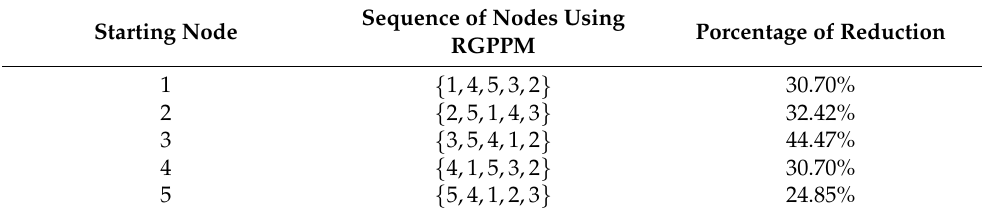
Table 10. Performance of the paths from Figure 3 by changing the start node.